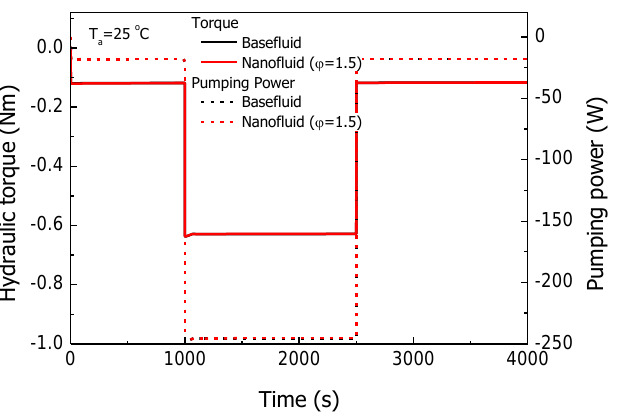
Figure 12. Torque and power results of the diesel engine with Al 2 O 3 nanofluids at 216 Nm step-load and 2050 rpm engine speed.